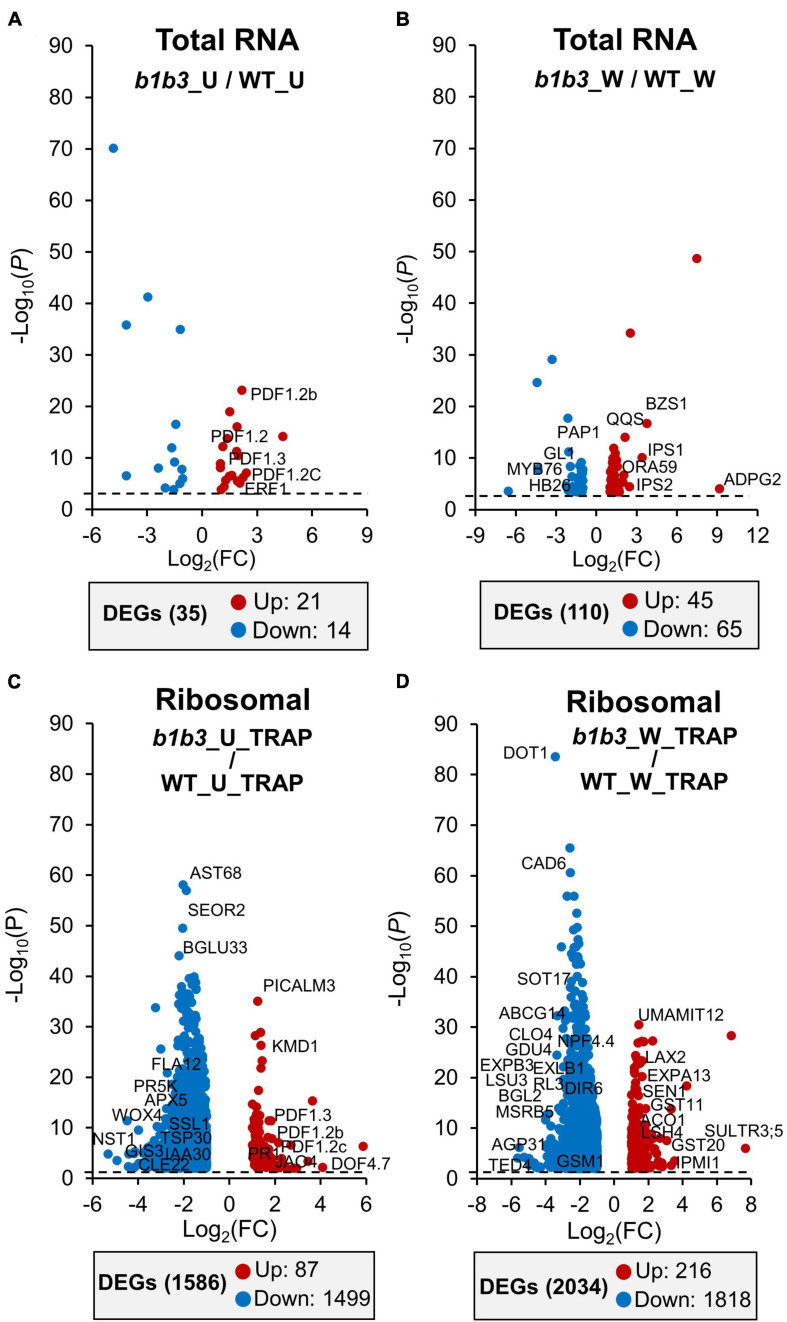
Transcript abundance comparisons between WT and b1b3 in the total and TRAP RNA pools. (A,B) Volcano plots of differentially expressed genes (DEGs) in total RNA of unwounded (U) (A) and wounded (W) (B) samples of WT and b1b3. (C,D) DEGs in TRAP RNA preparations of U and W leaf samples. Comparisons of log2FC of FPKM ≤ −1 and ≥ 1 per indicated sample were plotted (x-axis). Dotted line indicates the P value cutoff of < 0.05. Names of representative genes are displayed. Full list of gene names is provided in Supplementary Table 4. The numbers of up-regulated and down-regulated DEGs are shown in the gray boxes below each graph.